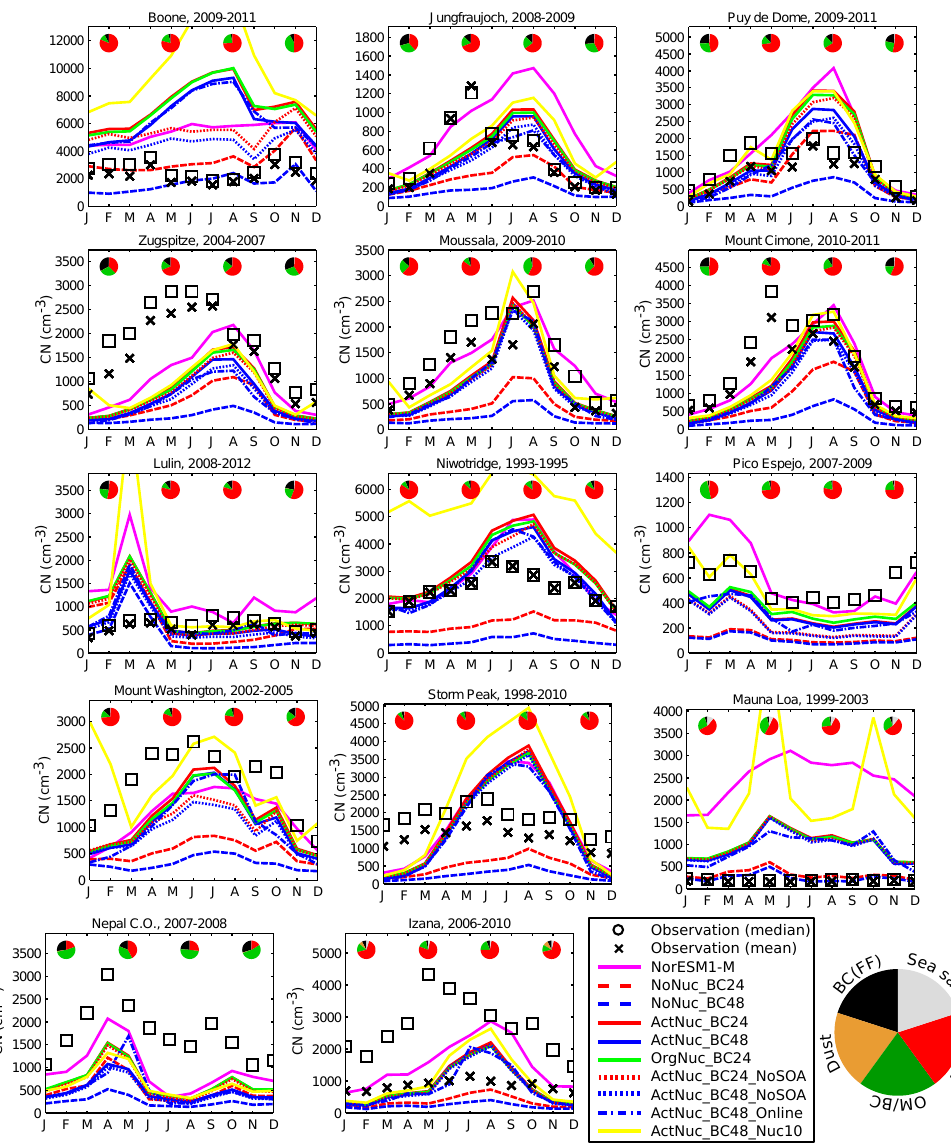
Figure 8. As Fig. 5, but for high-altitude sites (over 1000ma.s.l.).